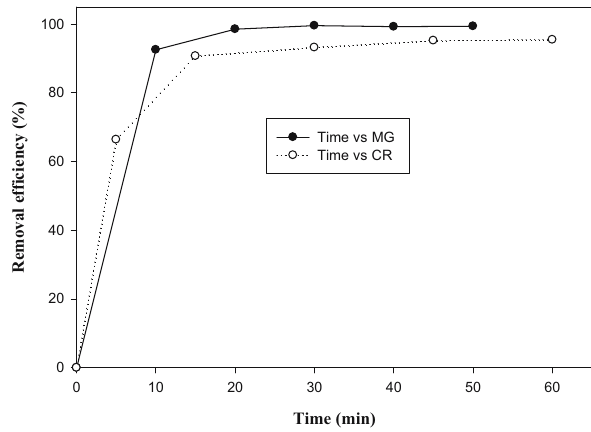
Figure 4: E ff ect of reaction time on the removal e ffi ciency. CR: pH 7.1, catalyst dosage = 150 mg L − 1 , [ H 2 O 2 ] = 0.05 mol L − 1 , initial [ CR ] = 30 mg L − 1 , temperature = 30°C. MG: pH 6.0, catalyst dosage = 100 mg L − 1 , [ H 2 O 2 ] = 0.05 mol L − 1 , initial [ MG ] = 30 mg L − 1 , tem - perature =